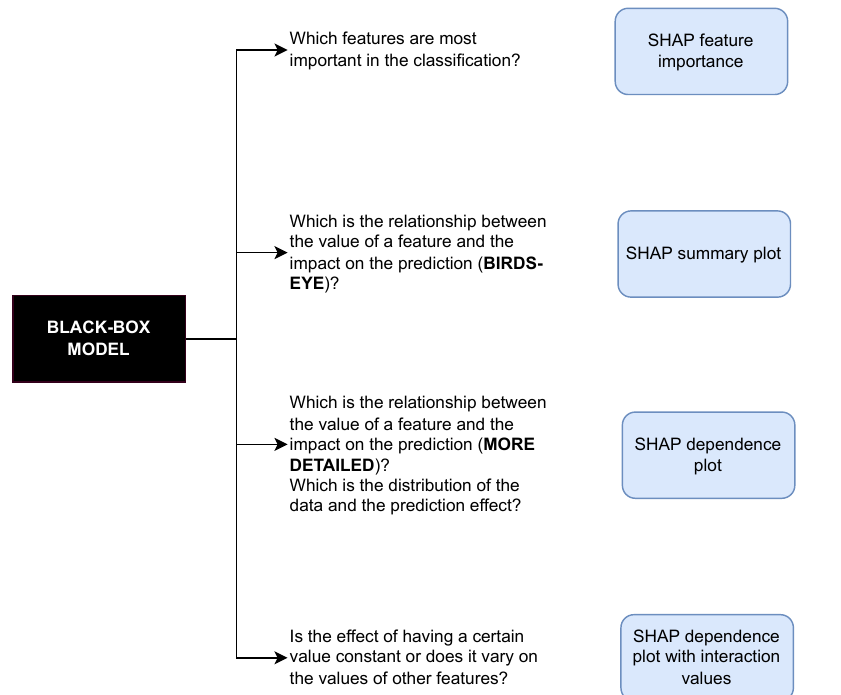
Figure 2. Guidelines for opening the black box model using the SHAP